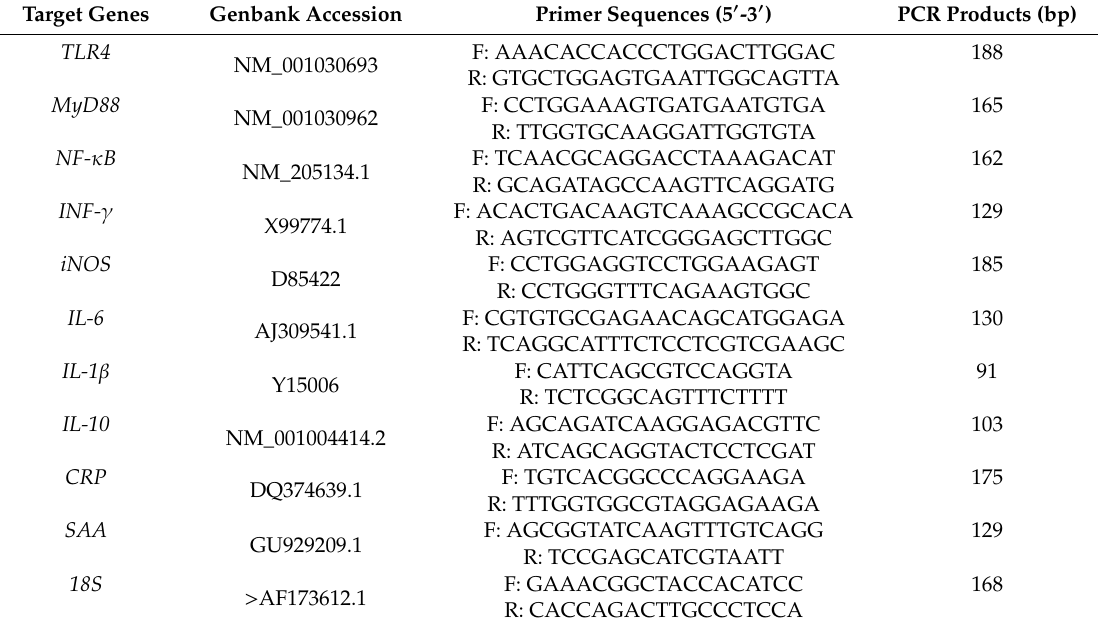
Table 2. Nucleotide sequences of specific